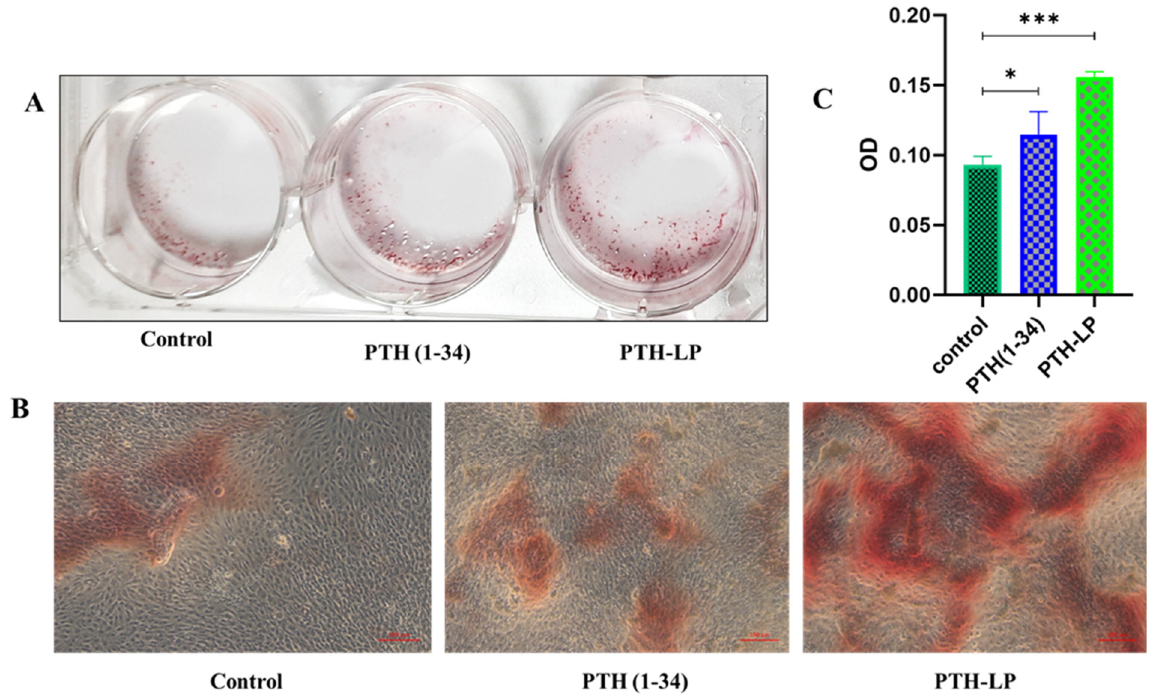
Figure 9. Assessment of mineralized nodule formation after the treatment of experimental groups. ( A ) Photographs of mineralized nodules (scale bar 100 µ m), ( B ) Microscopic images of mineralized nodules, and ( C ) Quantitative measurement of developed mineralized nodules. * p < 0.05, *** p <